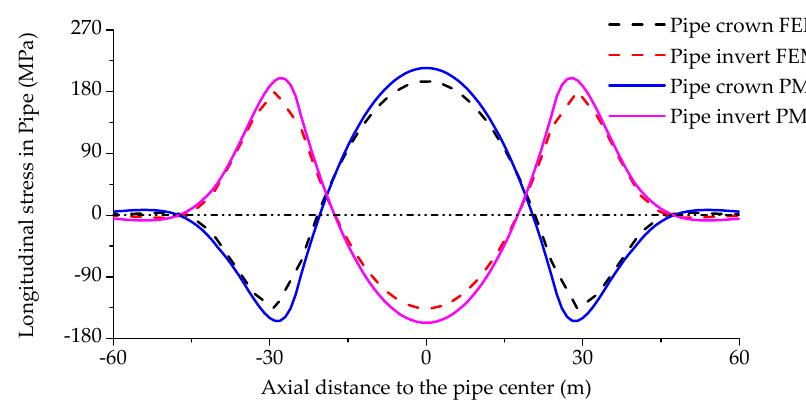
Figure 7. Comparative results of longitudinal stresses in pipe for Case 2 listed in Table 1.